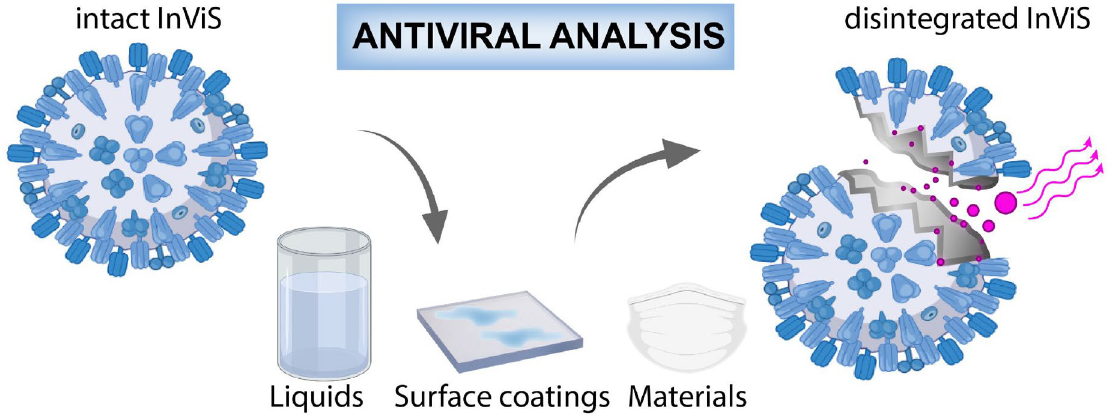
Figure 1. InViS, a fluorescent approach to detect viral envelope disintegration caused by antiviral